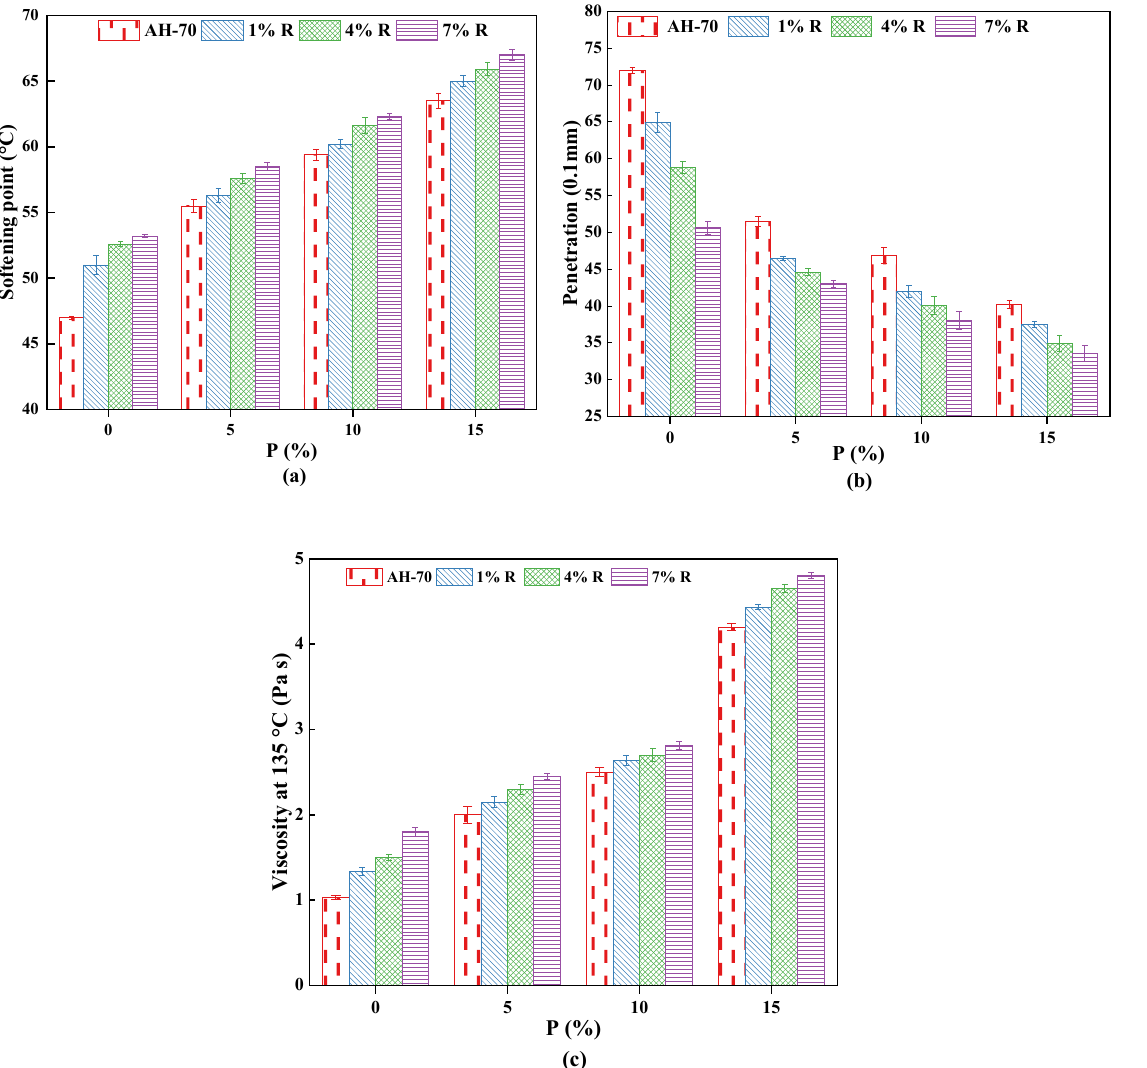
Figure 5. Effect of R/P, R, and P content on ( a ) softening point, ( b ) penetration, and ( c ) viscosity.